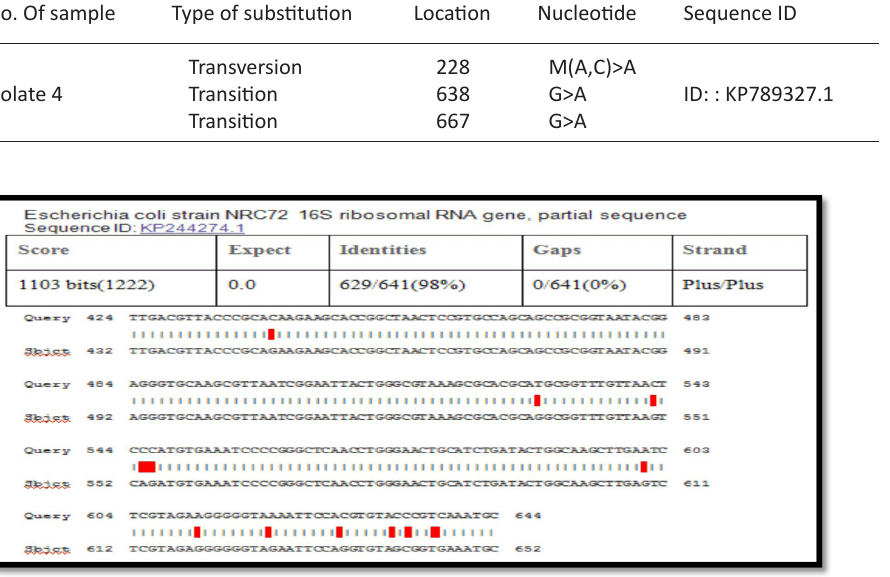
Table 4. Represent type of polymorphism of 16S rRNAgene from E. Coli isolate. No. Of sample